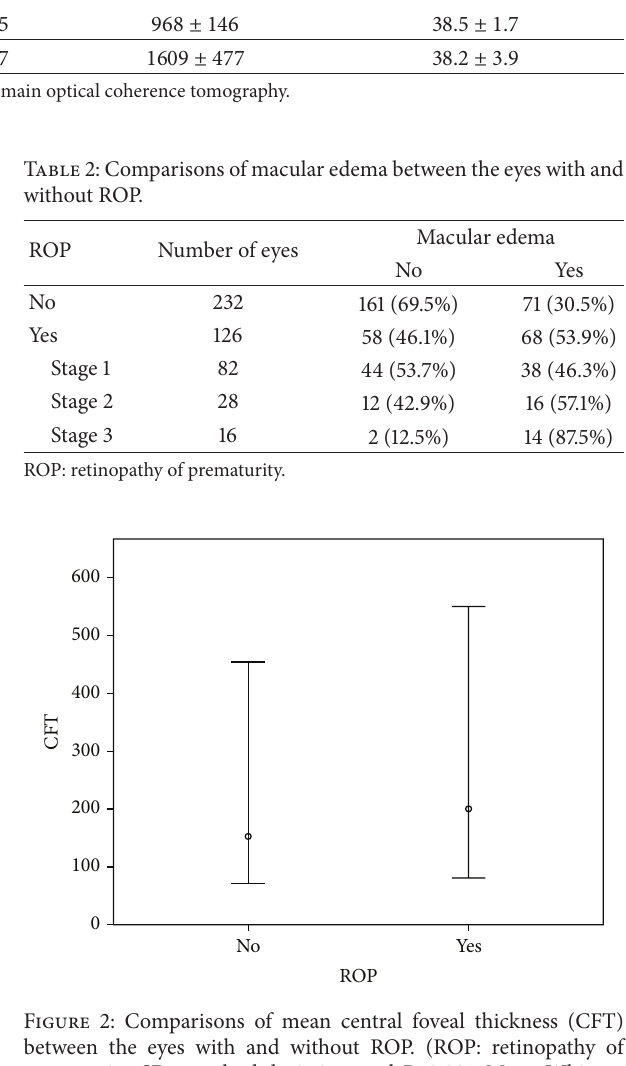
(Figure 4). Intravitreal ranibizumab injection was adminis- tered to five infants for treatment of Type 1 ROP at a mean postmenstrual age of 36.2±1.9 weeks. CFT increased in three infants and did not increase in two infants within one week after intravitreal ranibizumab treatment (Figure 5). Of the two infants in whom CFT did not increase, cystoid macular edema resolved in one infant two months after intravitreal ranibizumab injection (Figure 6). At the mean 38.2 ± 3.9 weeks of postmenstrual age, there was a weakly inverse correlation between CFT and gestational age ( 𝑃 = 0.025